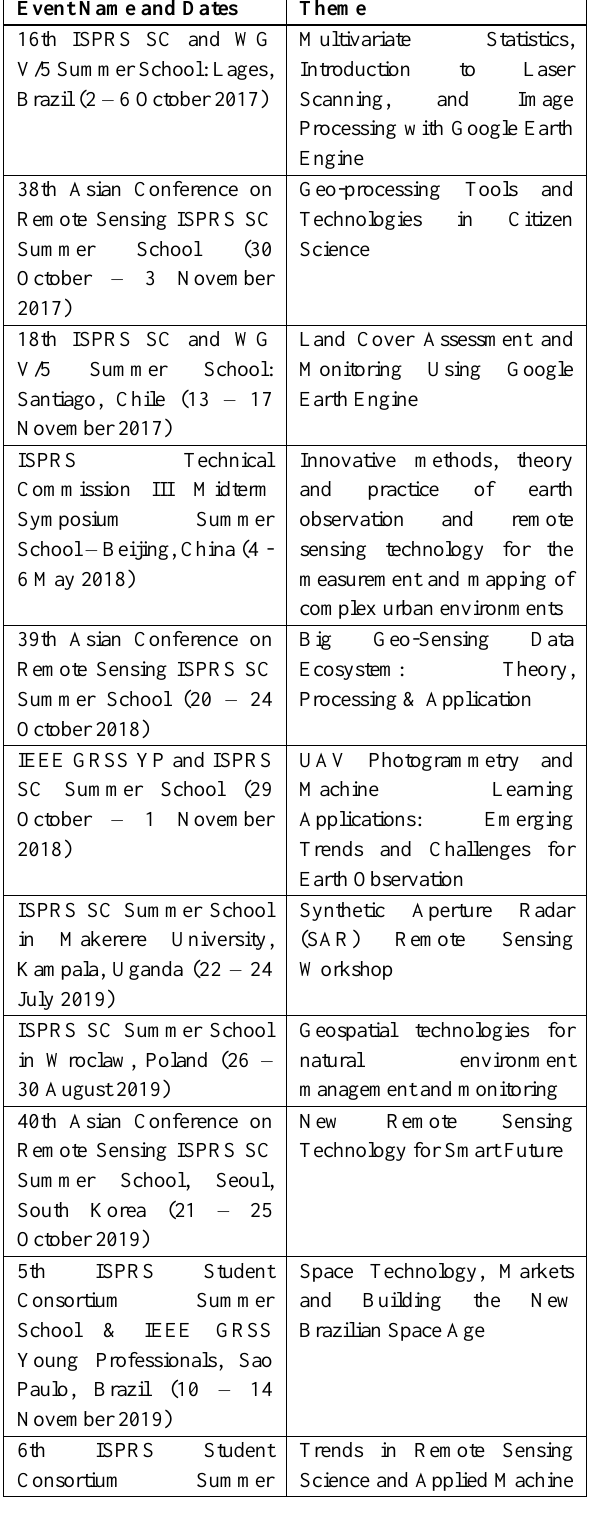
Table 3. The summer schools organized by the ISPRS SC in collaboration with local organizers across the globe from 2017 to